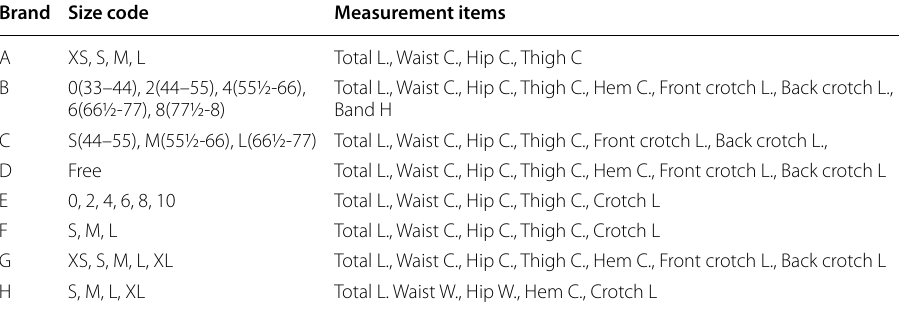
Table 5 Measurement items of commercial leggings by brand